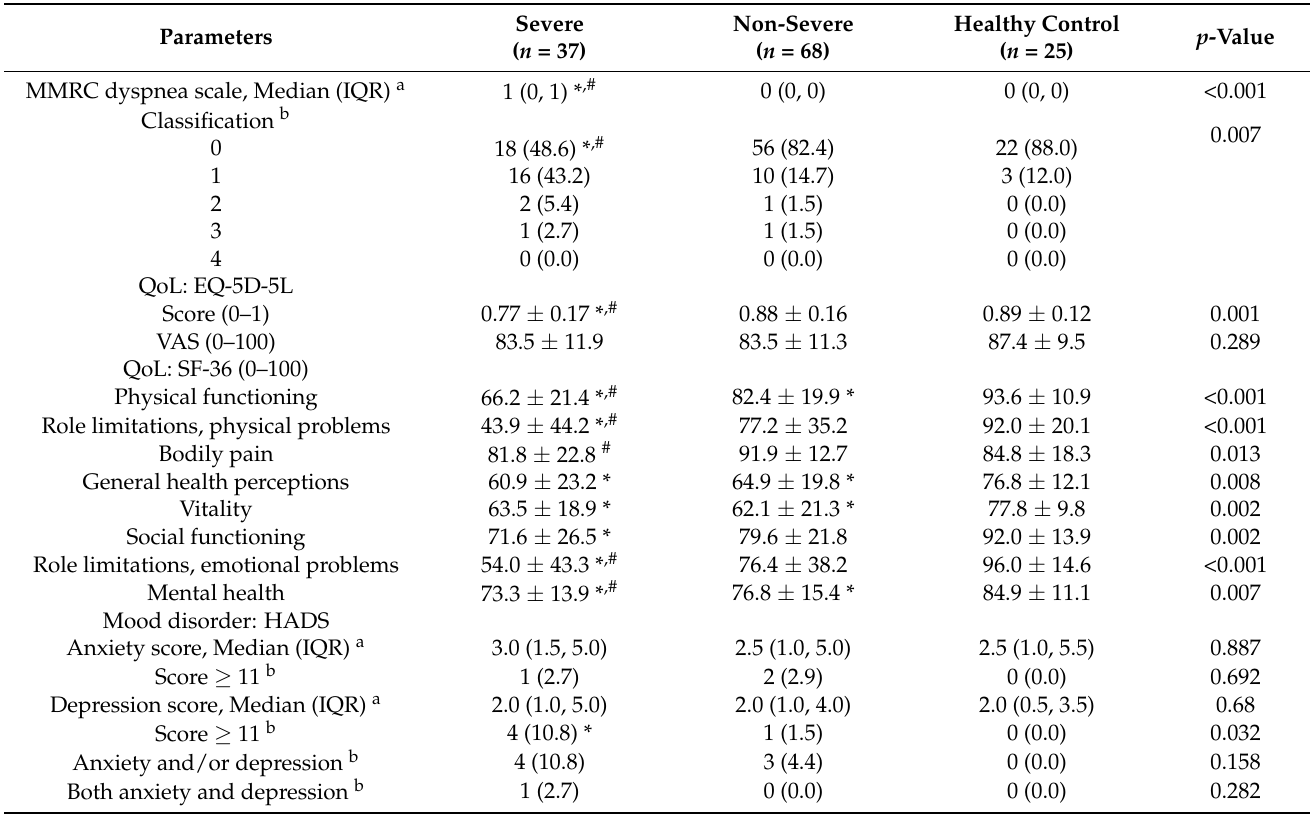
Table 4. Dyspnea, quality of life, and mood disorders at one-month follow-up visit.